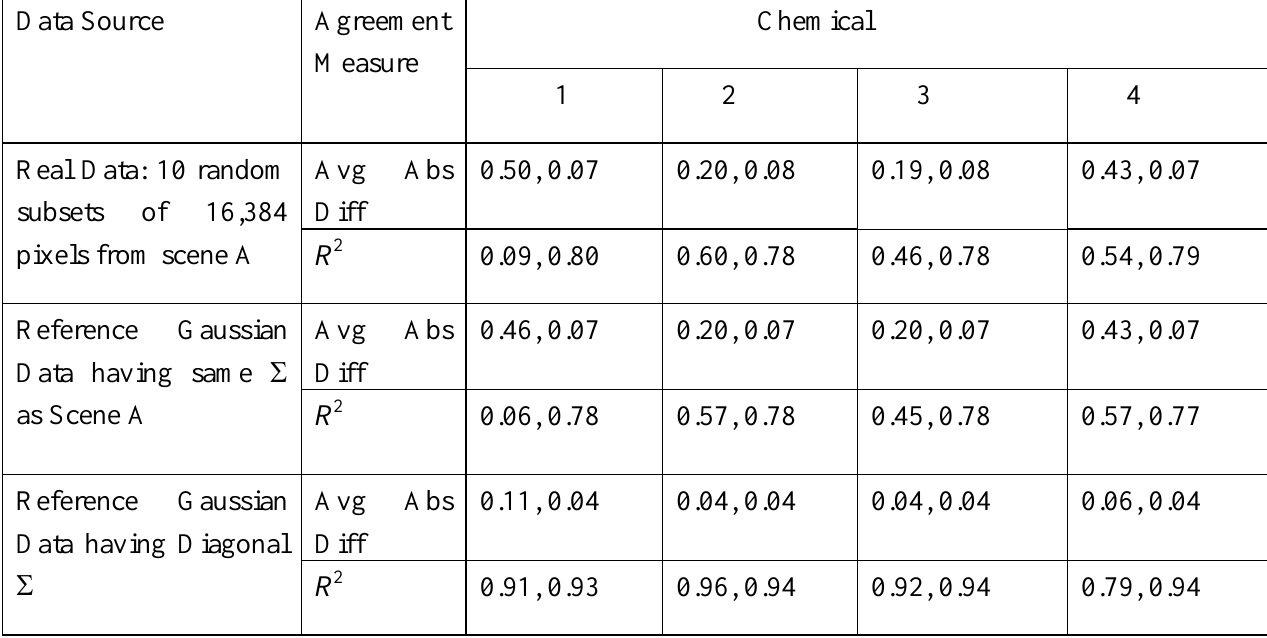
Table 4. The average absolute difference (and the R 2 describing the fit) between the estimated and observed probability of a chemical being present, for each of four chemicals, denoted as chemical 1, 2, 3, and 4. The first entry in each cell is for the case of four randomly-selected chemicals from the chemical library. The second entry is for the case of four random directions simulated from a Gaussian distribution. There are two simulated reference distributions. The first has the same mean and Σ as the real data, but is a SCMG; the second has a diagonal Σ with equal variances on the diagonal. Simulated data entries are within approximately 0.01 of a repeat of the 10 sets of 16,384 pixels. Real data entries would not vary if the 10 sets of 16,384 were analyzed